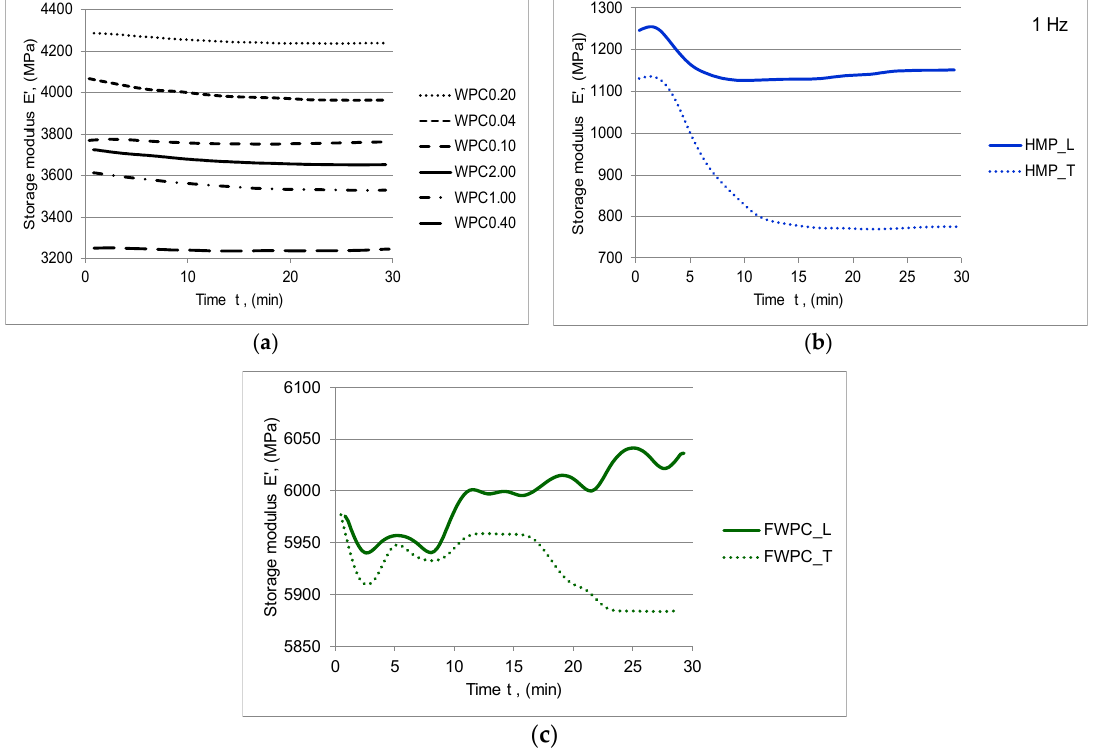
Figure 8 . Variation of the complex modulus in time: ( a ) WPC samples; ( b ) HMP samples; ( c ) FWCP samples.